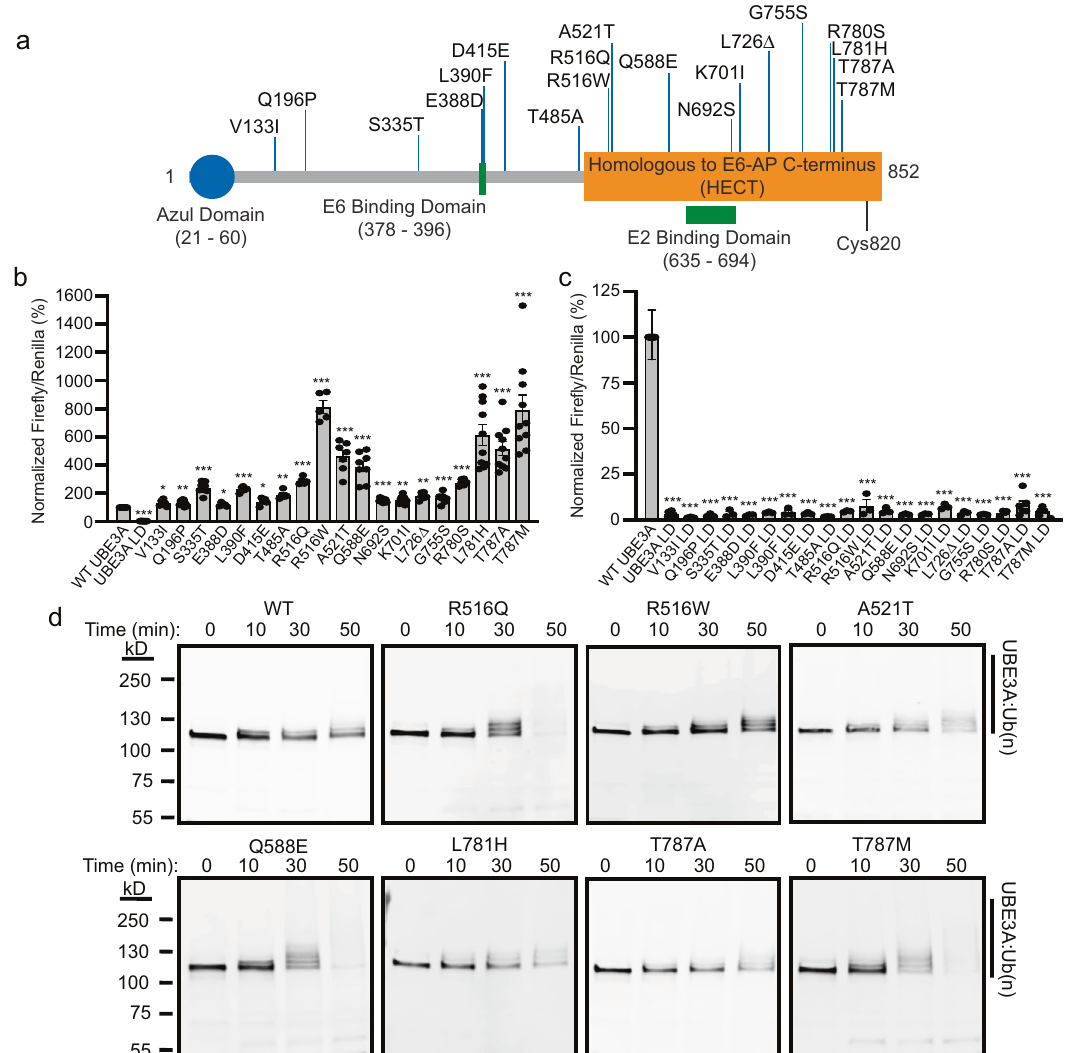
Fig. 3 Characterization of hyperactivating mutations in UBE3A. a Schematic of UBE3A showing the positions of hyperactivating mutations identi fi ed in our screen. b , c Normalized BAR responses of hyperactivating mutations with ( b ) and without ( c ) a ligase-dead (LD; C820A) mutation. BAR responses in b were re-plotted from the initial screen in Fig. 2 and are shown as the mean ± SE. Exact numbers of experiments and p -values for variants with ligase activity are provided in Supplementary Data 1. All variants for the LD were tested in three independent experiments and p -values calculated using a One-sample t - test (two-tailed) with Benjamini – Hochberg multiple comparisons correction (FDR = 0.05). V133I LD, *** p = 8.68 × 10 − 6 ; Q196P LD, *** p = 3.56 × 10 − 5 ; S33T LD, *** p = 1.49 × 10 − 4 ; E388D, *** p = 1.44 × 10 − 4 ; L390F LD, *** p = 1.20 × 10 − 4 ; D415E LD, *** p = 1.68 × 10 − 4 ; T485A LD, *** p = 2.36 × 10 − 5 ; R516Q LD, *** p = 1.55 × 10 − 5 ; R516W LD, *** p = 1.59 × 10 − 4 ; A521T LD, ** p = 0.0014; Q588E LD, *** p = 1.25 × 10 − 4 ; N692S, *** p = 1.37 × 10 − 5 ; K701I, *** p = 1.37 × 10 − 5 ; L726 Δ LD, *** p = 1.02 × 10 − 4 ; G755S LD, *** p = 6.25 × 10 − 5 ; R780S LD, *** p = 8.68 × 10 − 6 ; L781H LD, *** p = 1.44 × 10 − 4 ; T787A LD, *** p = 1.36 × 10 − 6 ; T787M LD, *** p = 1.25 × 10 − 8 . d In vitro ubiquitination assay was performed using UBE3A mutants expressed and puri fi ed from bacteria. Reactions were stopped at the indicated times and the formation of self-ubiquitinated UBE3A was monitored by western blot using an anti-UBE3A antibody. Representative images are shown from three independent experiments that produced similar